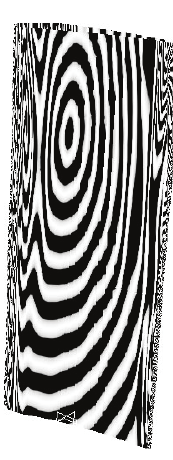
Figure 10: Blade reconstruction model.